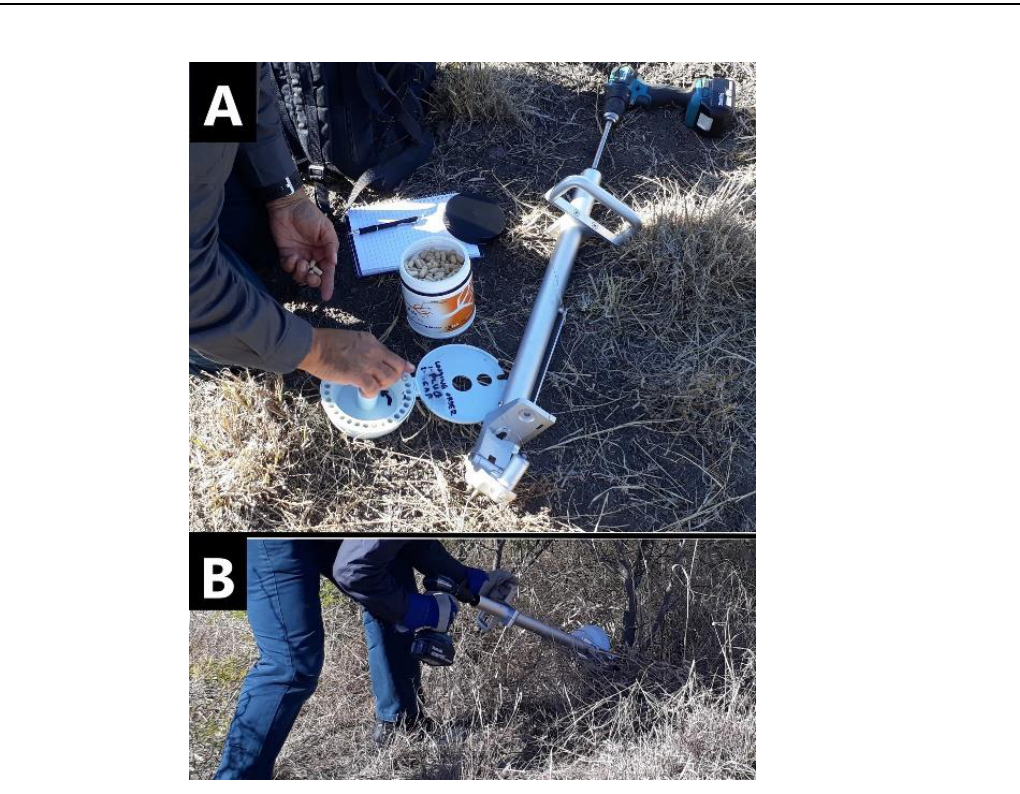
Figure 4. ( A ) Capsules are loaded into Injecta ® magazine followed by plugs; ( B ) stem implantation using Injecta ® .